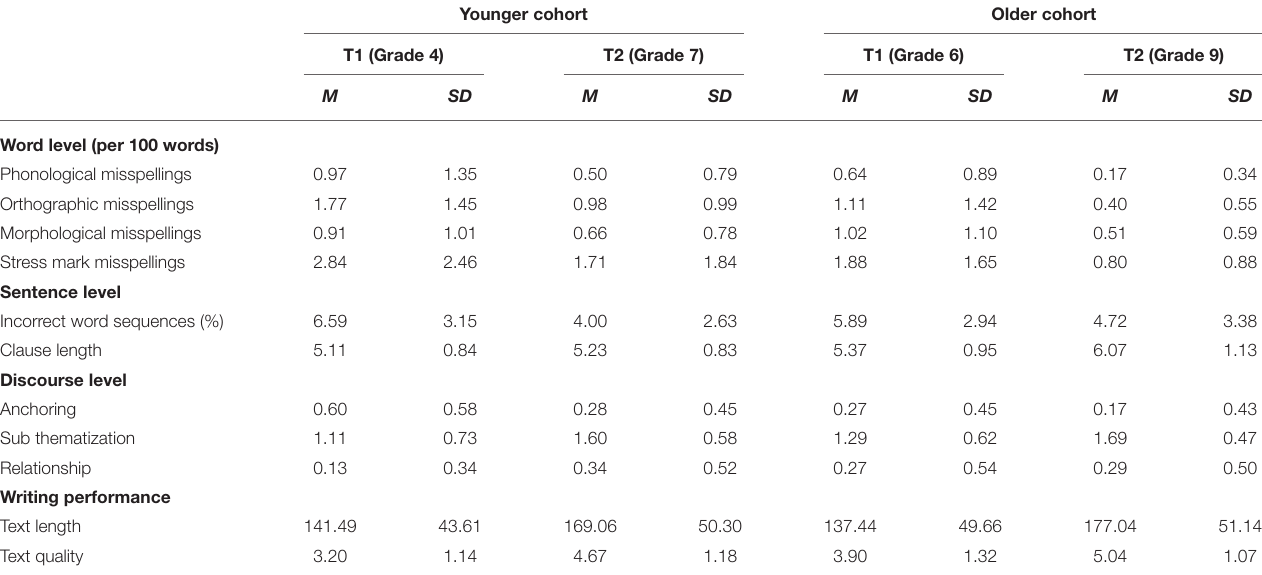
TABLE 1 | Means and SD for all variables by cohort and